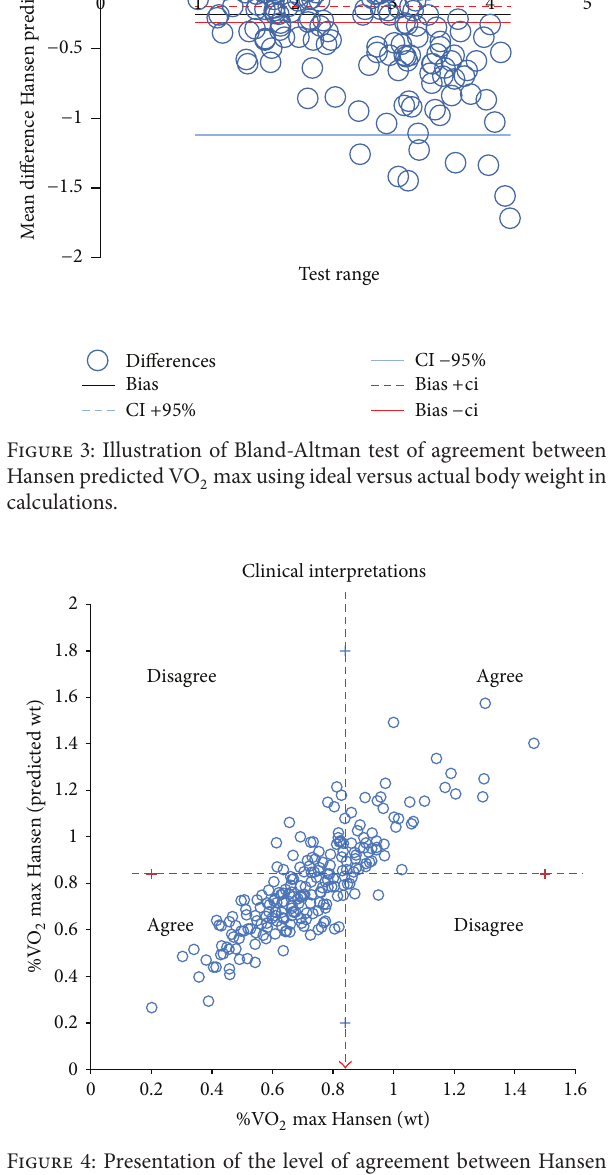
Figure 4: Presentation of the level of agreement between Hansen algorithmusingactualversusidealbodyweightstopredictVO 2 max ≤